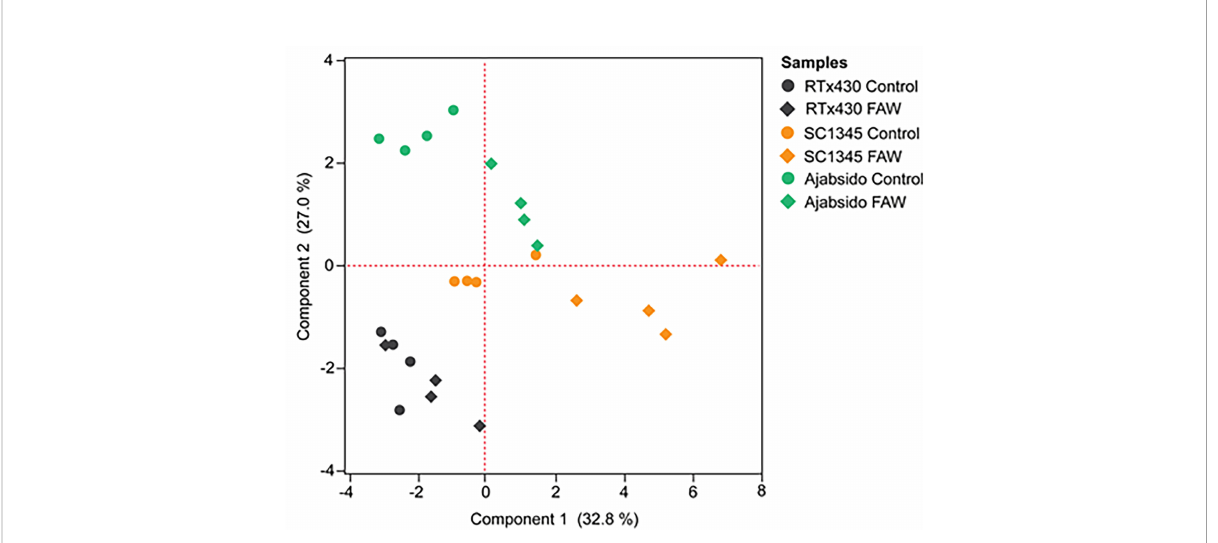
FIGURE 4 Principal component analysis (PCA) of fl avonoid compounds quanti fi ed after 10 days of fall armyworm (FAW) infestation on RTx430, SC1345 and Ajabsido plants. FAW-uninfested plants were used as